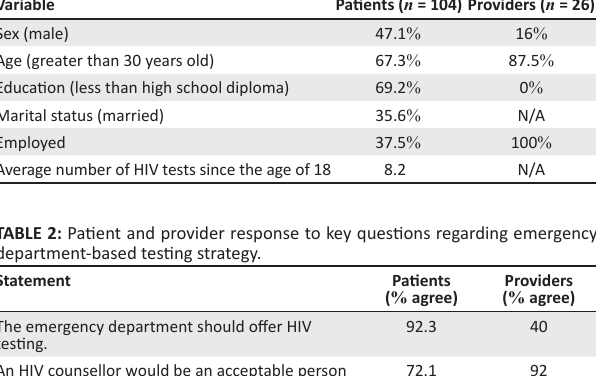
TABLE 1: Distribution of demographic characteristics of patients and providers in Frere Hospital, East London, South Africa. Variable